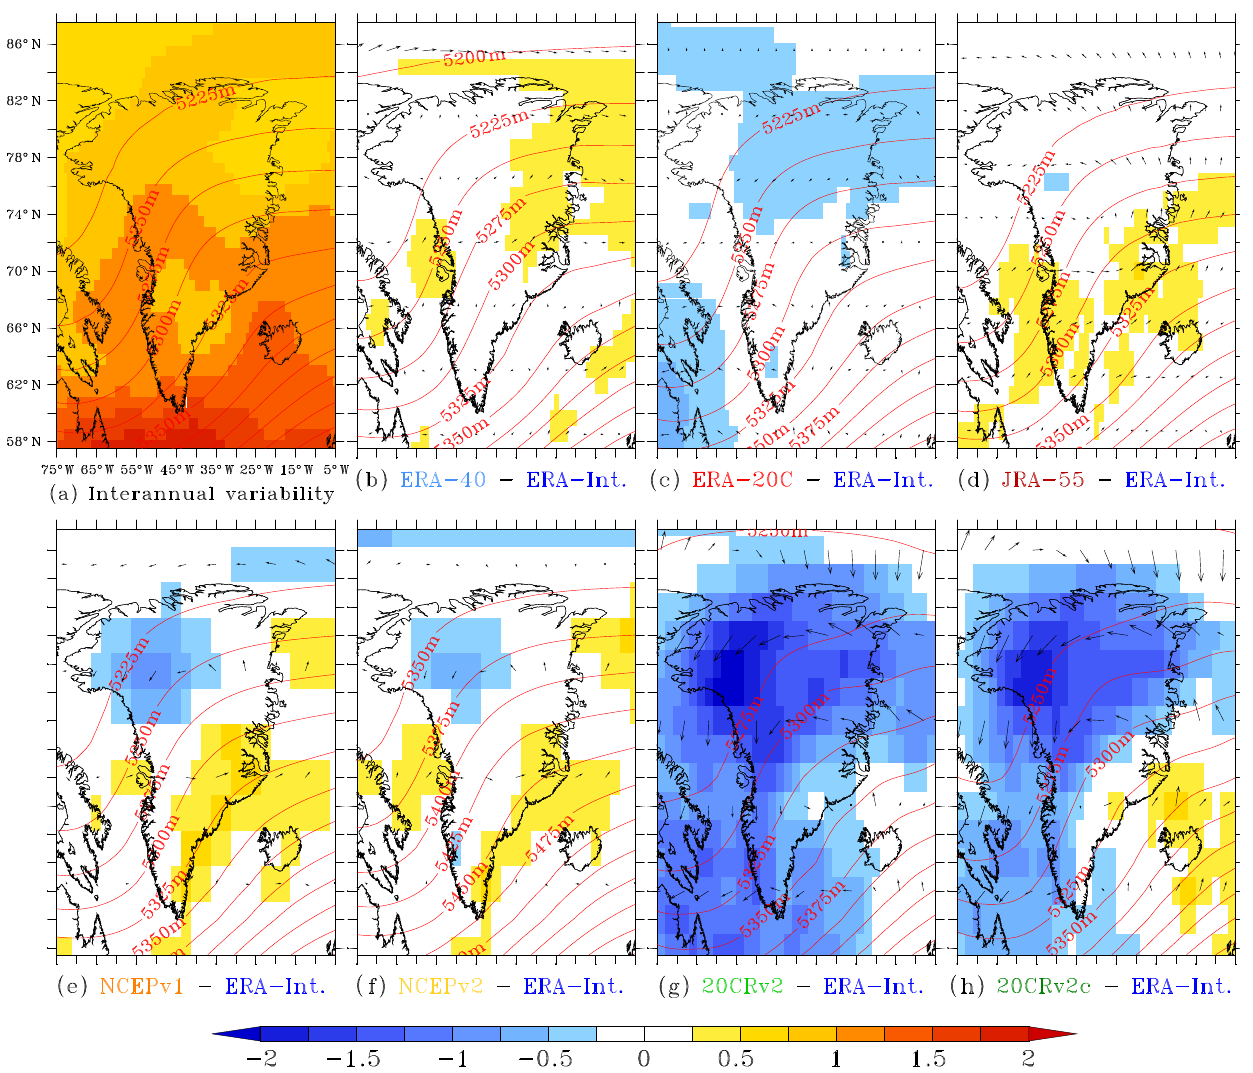
Figure 2. Idem as Fig. 2, but for the mean annual geopotential height (Z500) at 500hPa over 1980–1999. Units are metres. The wind vectors represent anomalies of wind